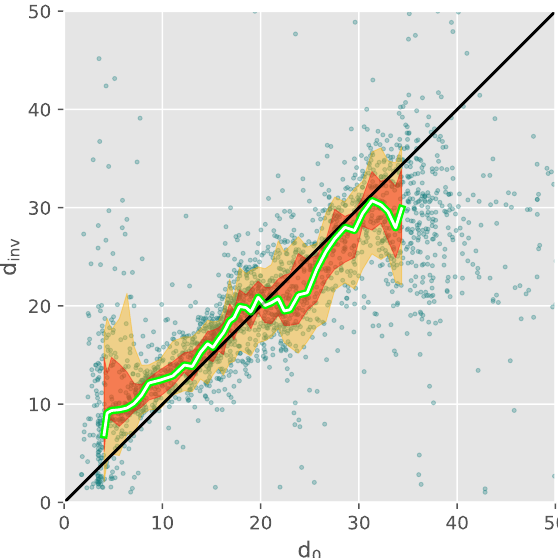
Figure 6. Direct comparison of inverted depths, d inv against ground truth, d 0 (blue dots). The median is indicated in green and aims to approximate the black 1:1 line. The 25th–75th percentile is shaded red and superimposed on the 10th–90th percentile shaded